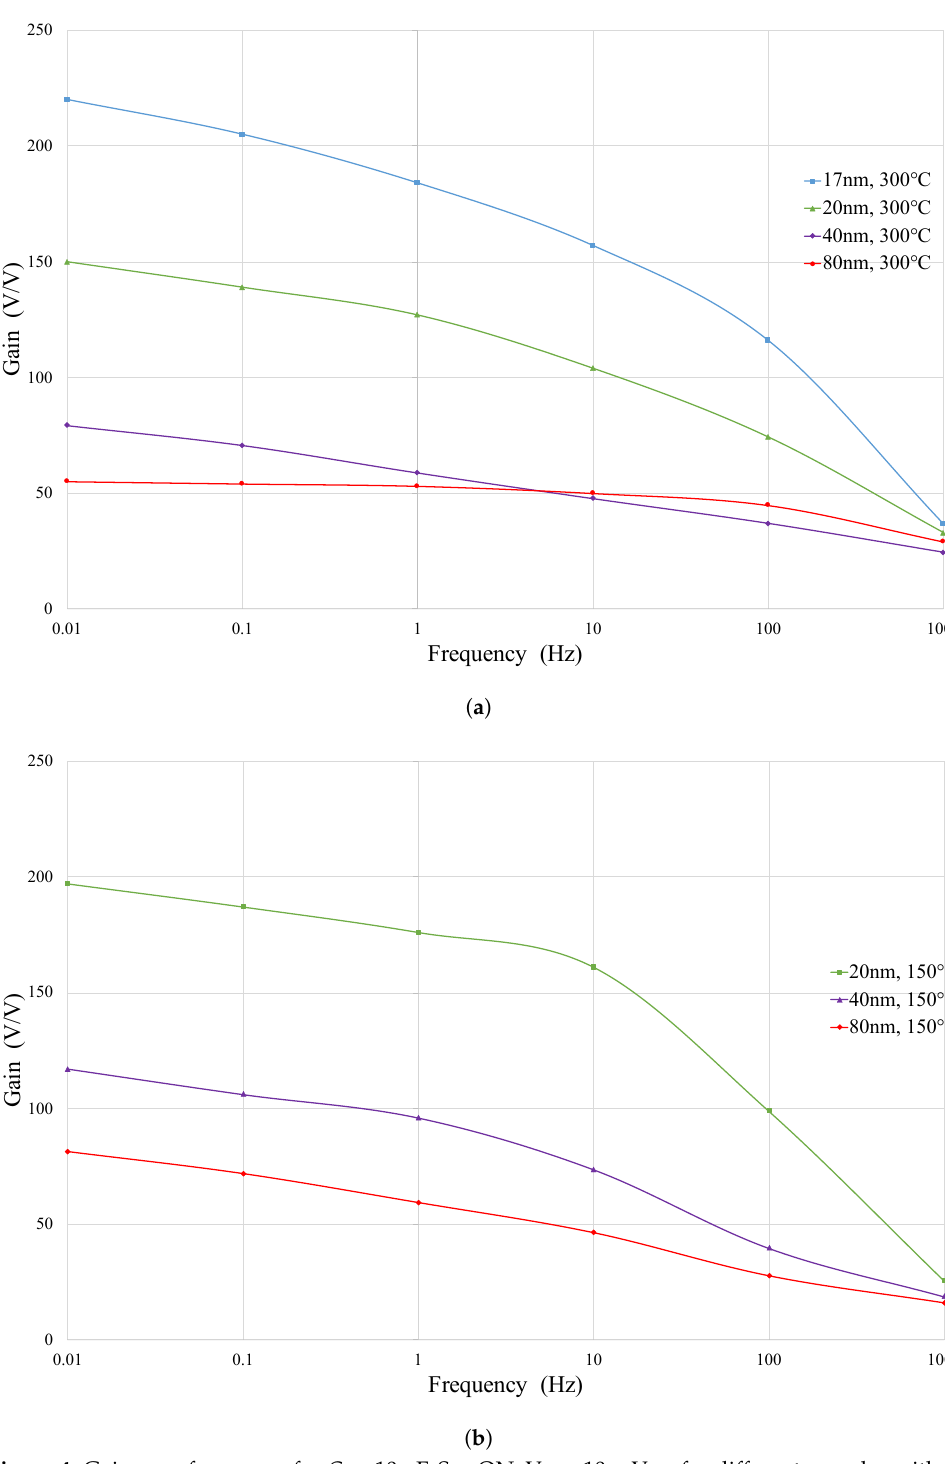
Figure 4. Gain over frequency for C f = 10 nF, S 2 : ON, V in = 10 mVpp for different samples with 17, 20, 40, and 80 nm thickness deposited in ( a ) 300 °C and ( b ) 150 °C. As shown, when the frequency is further reduced ( < 10 mHz), the gain becomes more stable and the capacitance value is more accurate. The measured value of the capacitance of the samples over thickness is depicted in Figure 5. Using (3), the sample capacitance can be